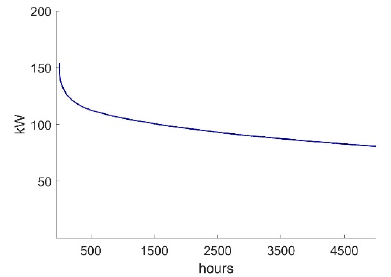
Figure 4. Duration curve for household electricity demands.